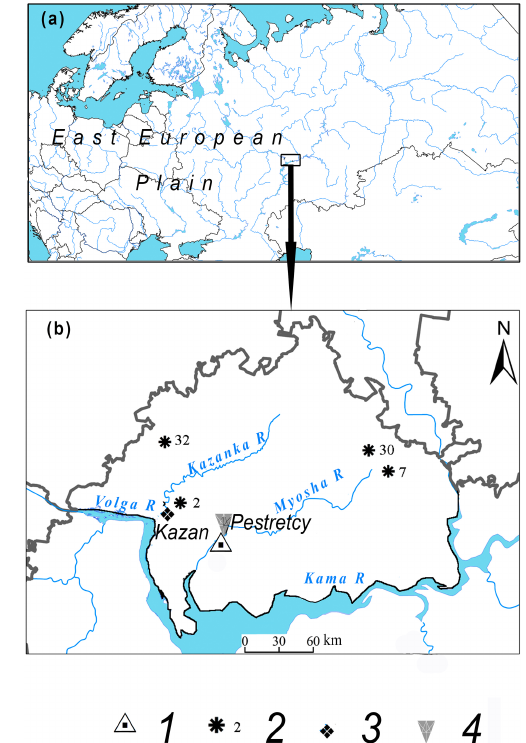
Figure 1. The location of the Pre-Kama region in the Russian Plain (a) and the Republic of Tatarstan (b) . (Legend: 1 – the study region, 2 – the study sites with measurement of GHRR, based on the interpretation of high-resolution satellite images, 3 – the study sites with measurement of GHRR, based on a monitoring, 4 – the Kazan-Opornaya meteorological station, 5 – the Pestretcy gauging station (at the Myosha